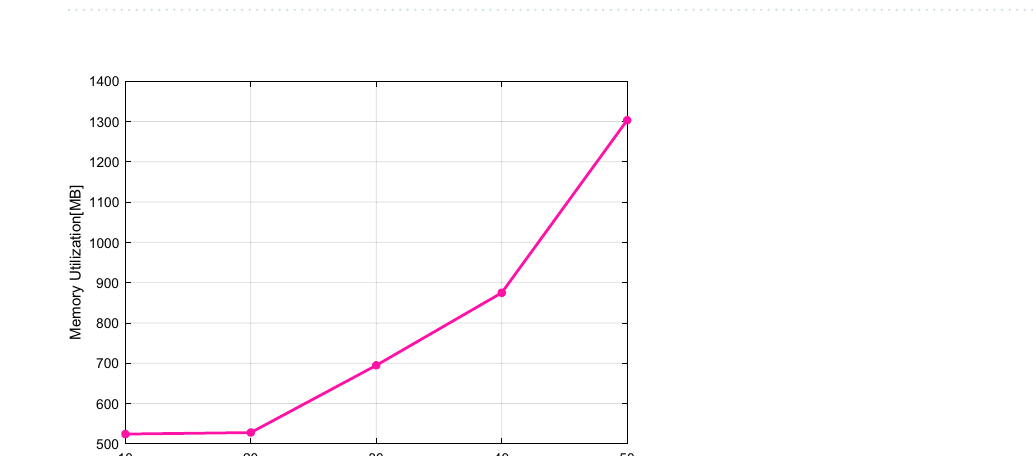
Figure 12. The run-time on the fog server.